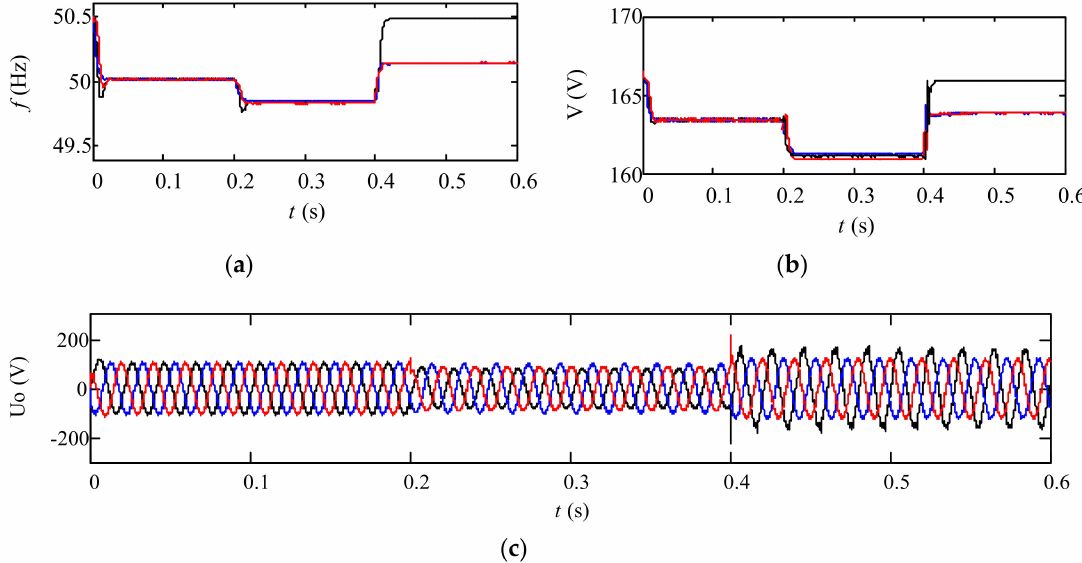
Figure 11. Voltage waveforms with the traditional droop control. ( a ) Frequencies of the three-phase reference voltage; ( b ) amplitudes of the three-phase reference voltage; ( c ) instantaneous output